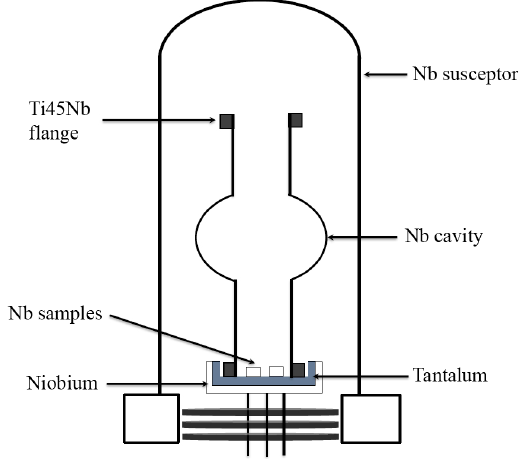
FIG. 12. Schematic of the cavity and samples inside the